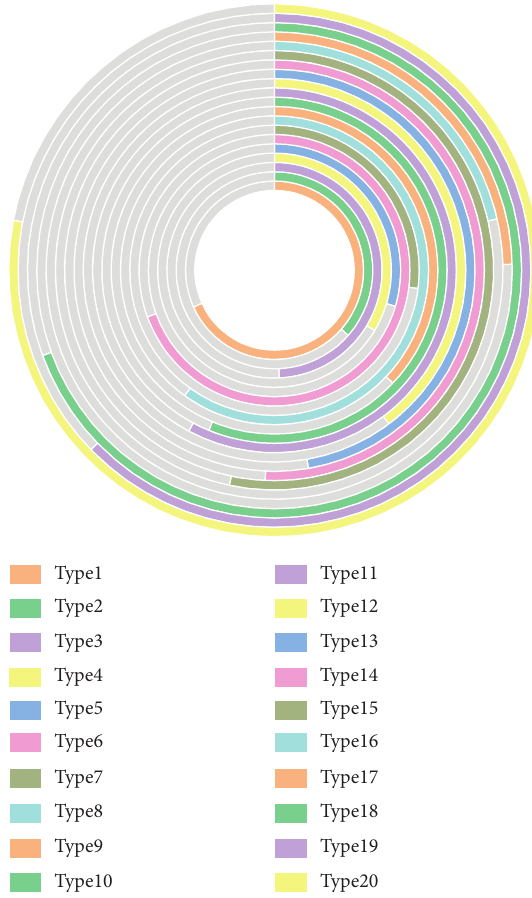
Figure 4: Statistical map of the pathways to understanding smart